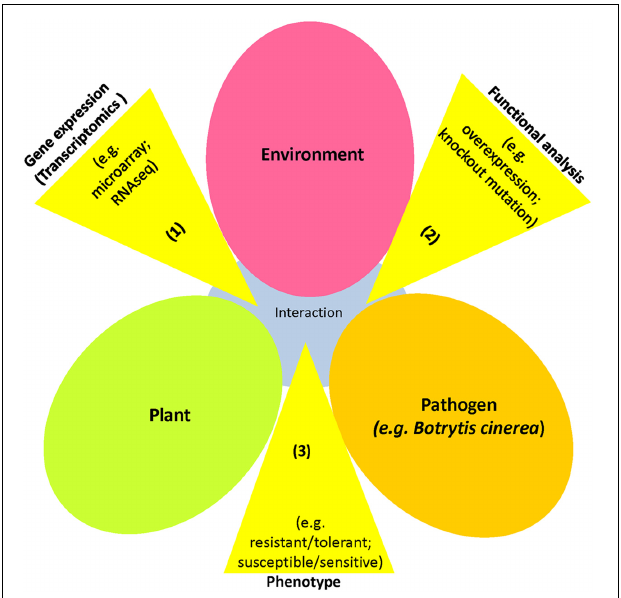
FIGURE 2 | An overview of reverse genetics approach used in gene discovery. Disease triangle of plant-pathogen-environment interactions. In reverse genetics, the sequence of the gene is identified, but the function is not known. Steps of reverse genetic analysis: (1) Transcriptome analyses during the plant-pathogen interaction to identify differentially expressed genes; (2) Candidate genes can be identified and functionally characterized (e.g., overexpression, knockout); and (3) phenotypic effects of candidate genes can be determined (resistance/tolerance or susceptibility/sensitivity). Reverse genetics studies are commonly used to produce plant varieties resistant to pathogenic microbes, such as Botrytis cinerea